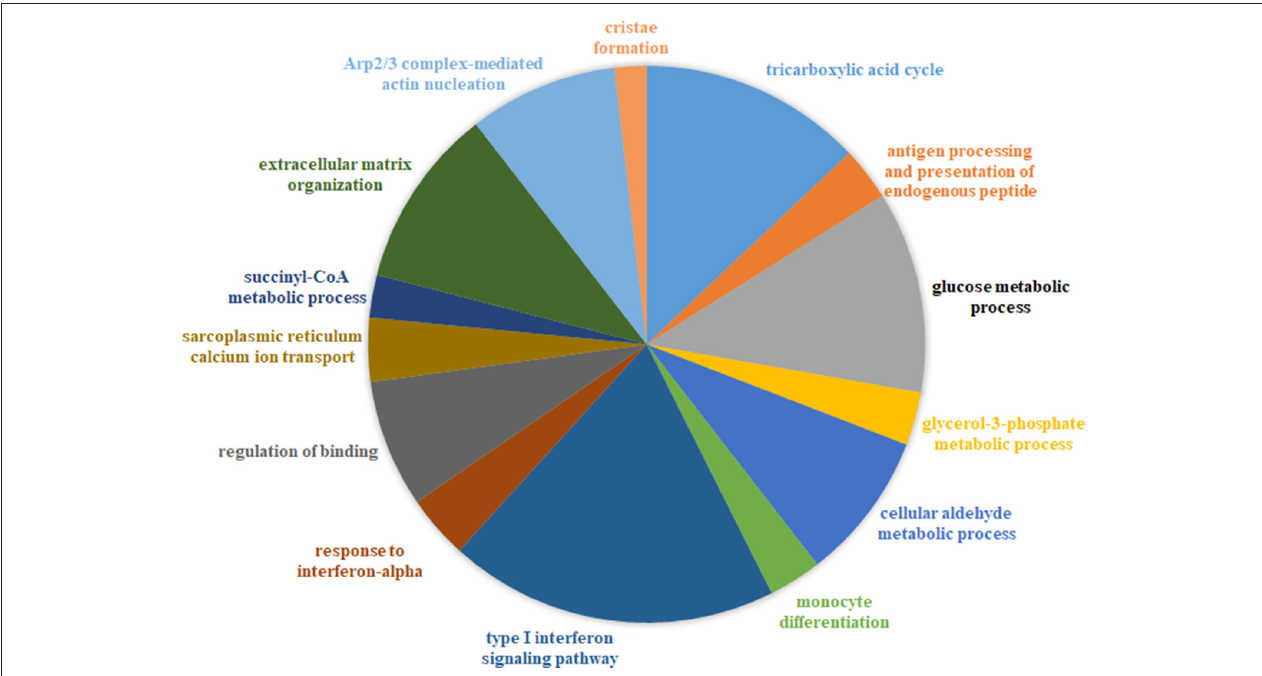
FIGURE 2 | Combined functional enrichment of protein signature underlying diseases affecting the muscle. This figure provides a graphical representation of the top enrichment terms identified in the 17 signature protein modules (combined). The signature modules represent a set of modules that were identified as underlying a majority of the diseases considered in this study Size of each section of the pie is proportional to the number of genes identified in each category.